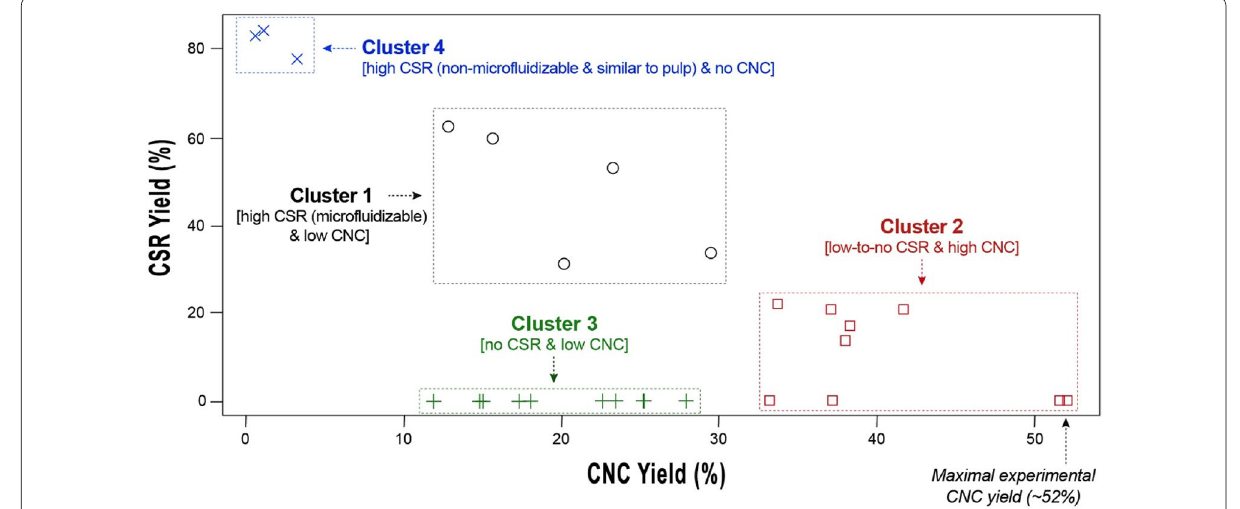
Fig. 1 Cluster analysis of experimental CNC and CSR